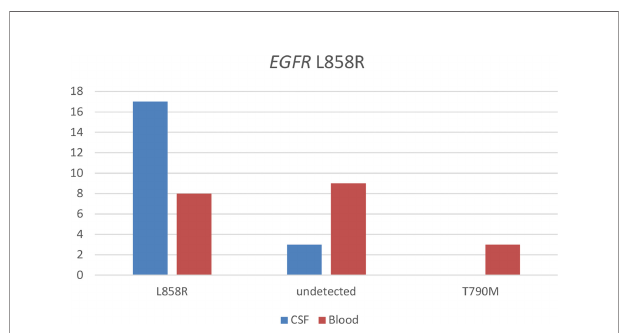
FIGURE 2 | Detection of somatic mutations in paired cerebrospinal fl uid (CSF) and blood samples of patients with EGFR -mutated non-small cell lung